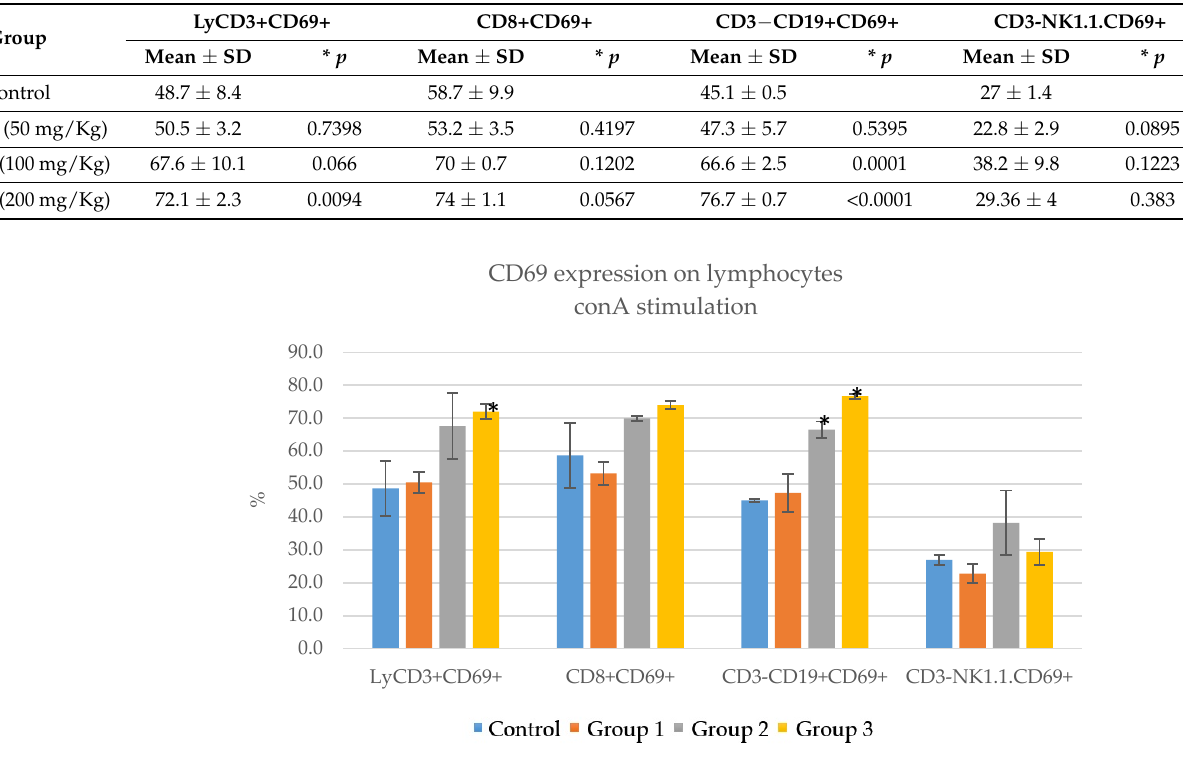
Figure 13. CD69 expression on lymphocytes in the groups that received ImunoBoost compared to the control group—stimulation with conA; * = p value < 0.05.